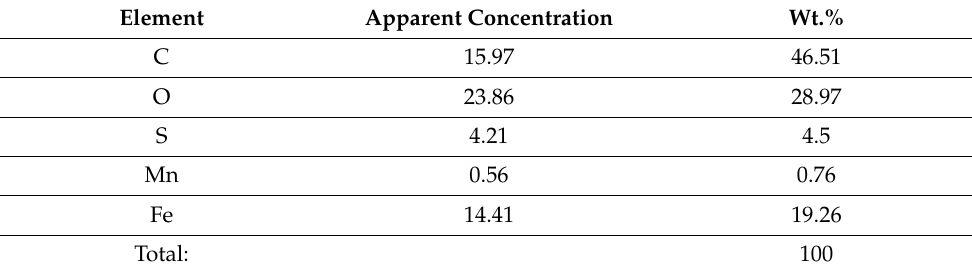
Table 3. EDX data of 7%S@MnFe 2 O 4 nanoparticles.